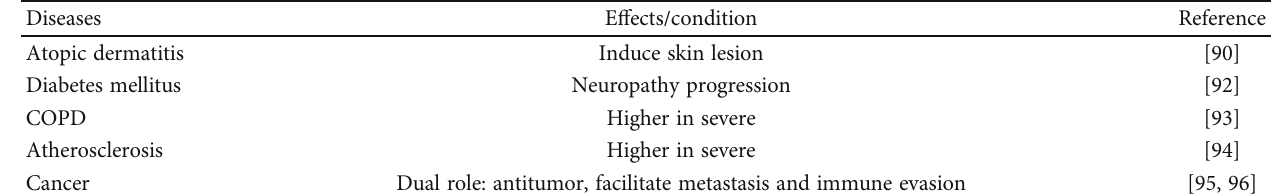
Table 3: IL-18 role in other